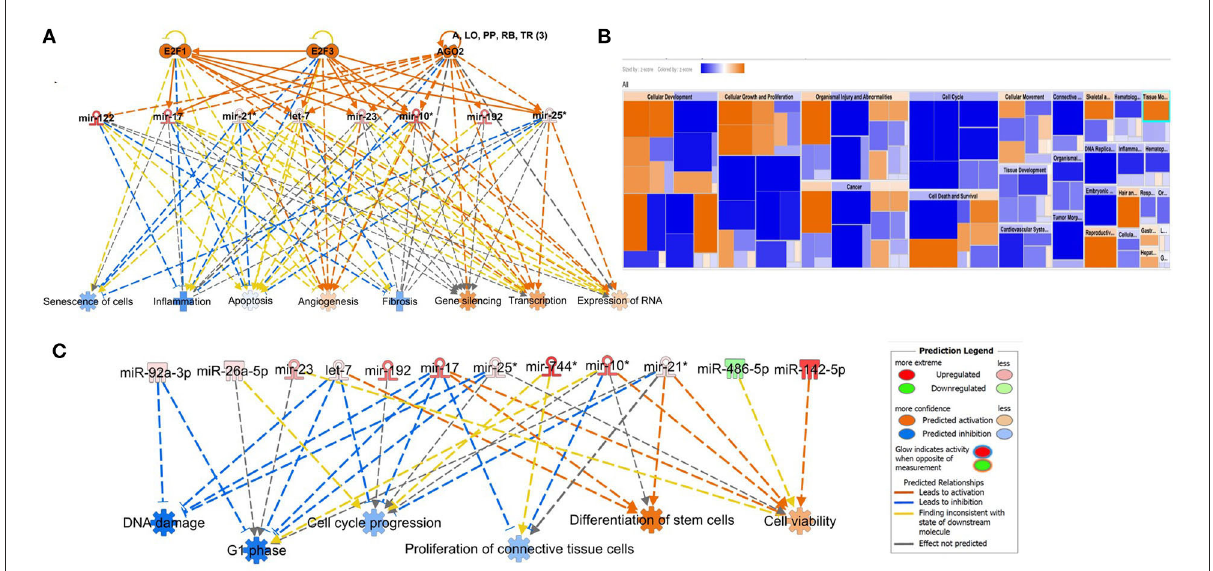
FIGURE10 Pathway analysis of differentially expressed (DE) miRNAs in synovial fluid following small RNA sequencing using IPA. (A) Regulatory effect network for E2F1, E2F3, and AGO2 action, senescence, inflammation, apoptosis, angiogenesis, fibrosis, gene silencing, transcription, and expression of RNA via differentially expressed miRNAs. (B) Heatmap sized by the Z -score of biological processes with a scale where blue is inhibited and orange is activated. (C) Significant diseases and functions based on Z -score associated with DE miRNAs. Figures are graphical representations of molecules identified in our data in their respective networks. Red nodes are upregulated and green nodes are downregulated gene expression. Intensity of colour is related to higher fold-change. Legends for the main features in the networks are shown. Biological function is dependent on whether it is predicted to be activated or